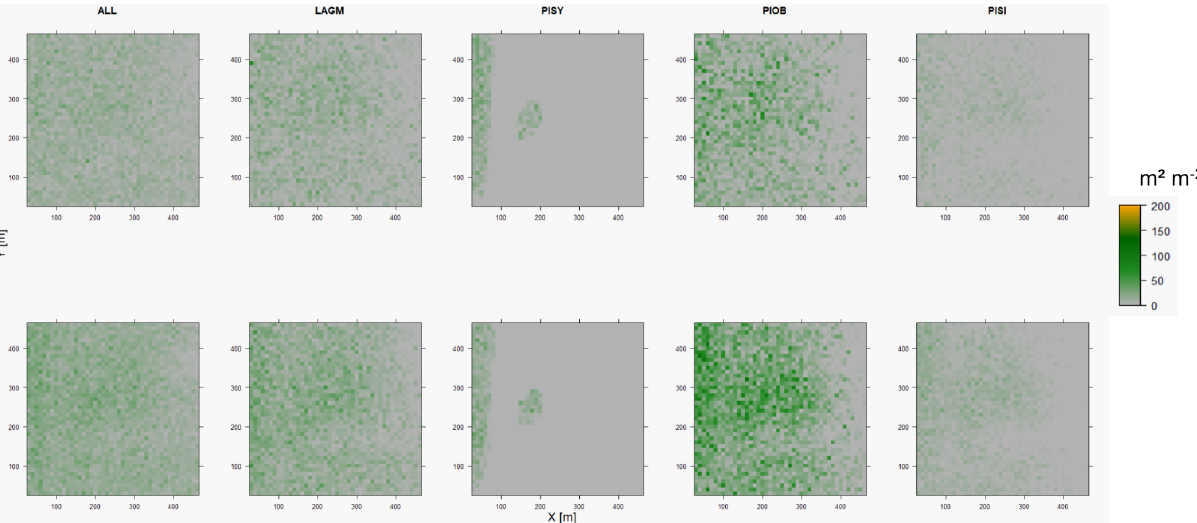
Figure D2. Leaf area index (LAI) values of the CryoGrid grid aggregated at year 2020 at Lake Khamra. Upper row shows LAVESI–CryoGrid coupled; lower row shows LAVESI simulations. LAGM: Larix gmelinii ; PIOB: Picea obovata ; PISI: Pinus sibirica ; PISY: Pinus sylvestris